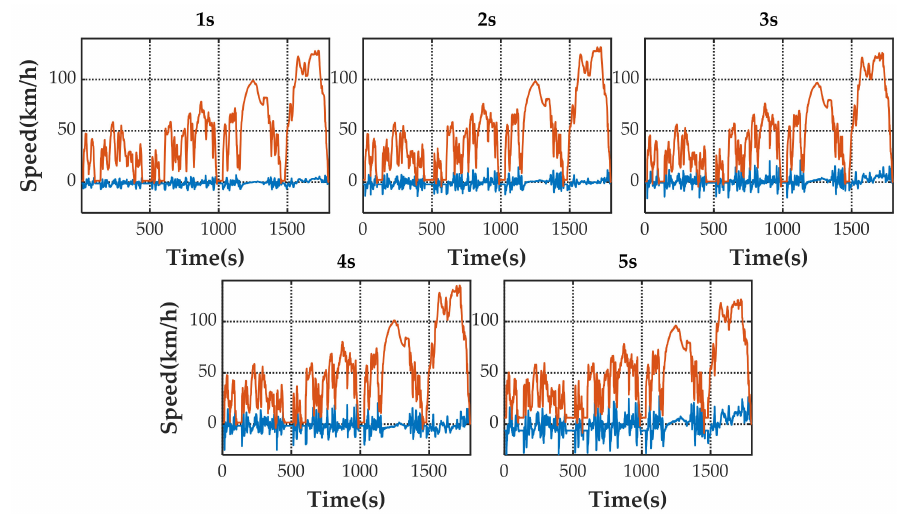
Figure 7. The prediction error (blue) and prediction speed (orange) of SVM.